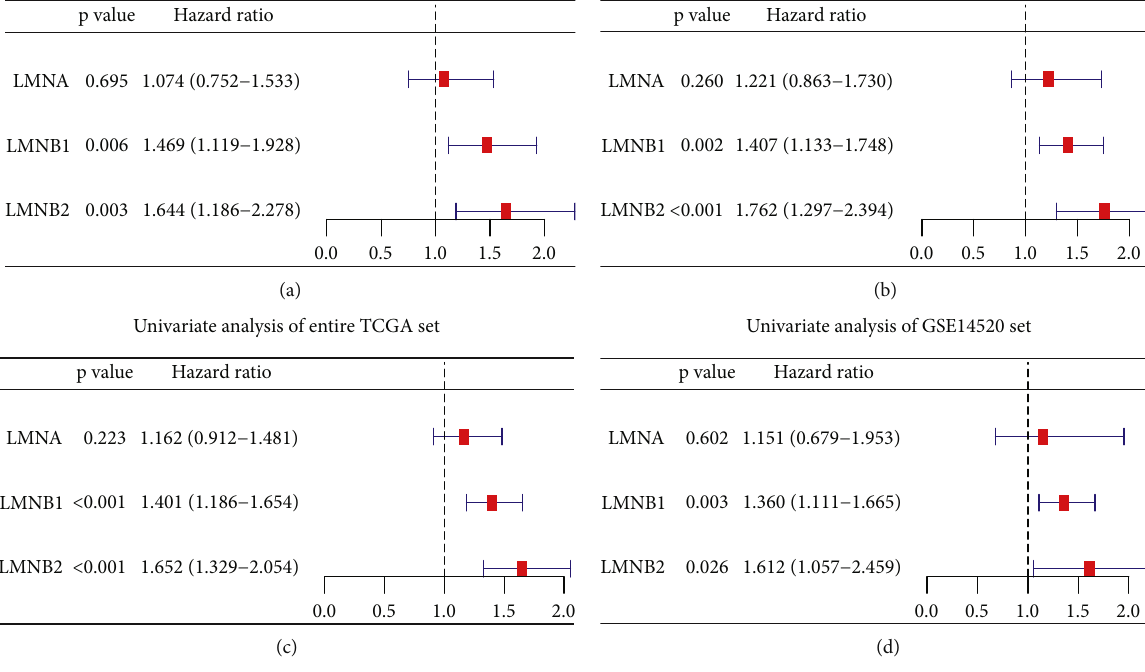
Figure 3: Univariate Cox regression analyses of the lamin family members in HCC datasets. (a) TCGA training set. (b) TCGA test set. (c) Entire TCGA set. (d) GSE14520